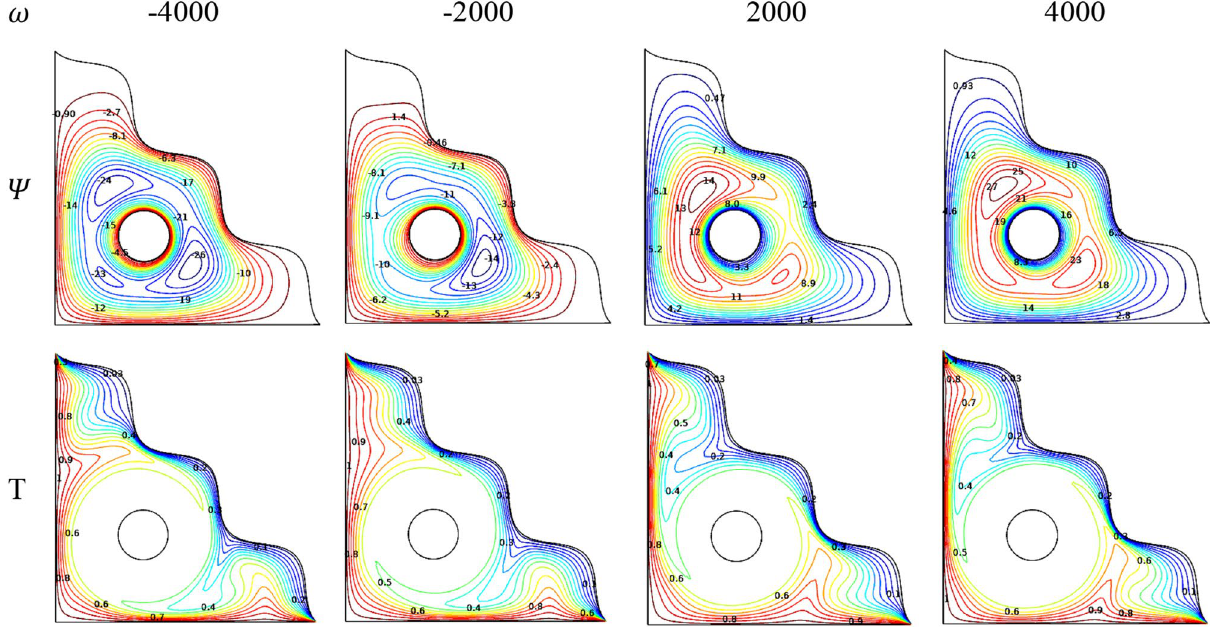
Figure 22. Variations of the streamlines ( (cid:31) ) and isotherms ( T ) with ω at Ra = 10 6 , Ha = 0 , Da = 0.01 , ε = 0.2 , N = 4 , r = 0.1 and φ = 0.02